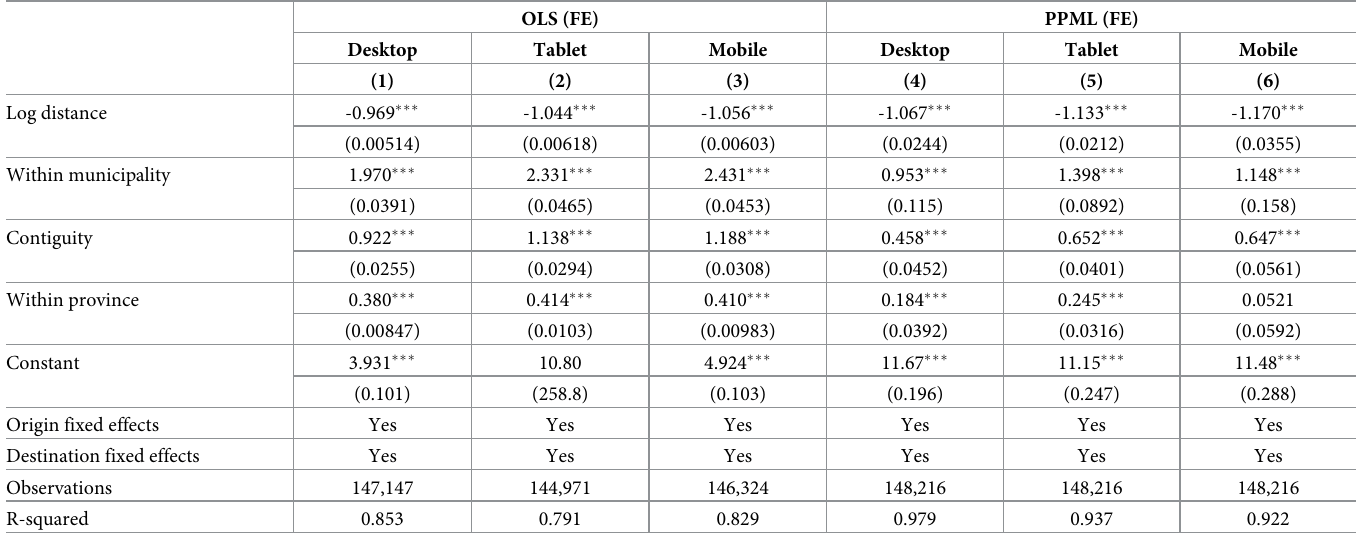
Table 7. Estimation results for device categories.